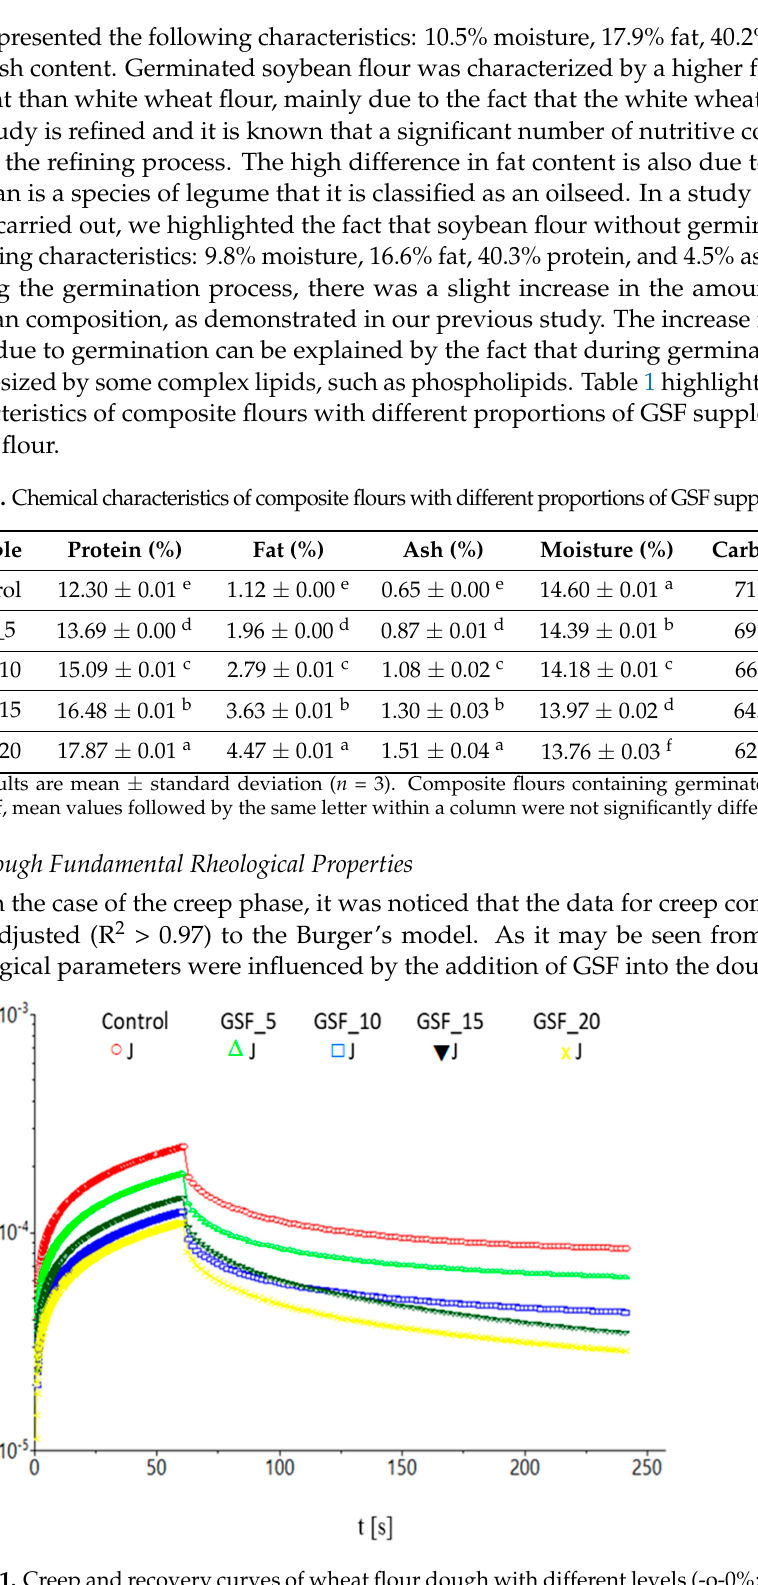
Figure 1. Creep and recovery curves of wheat fl our dough with di ff erent levels (-o-0%; - ∆ -5%; - □ -10%; - ▼ -15%; -x-20%) of germinated soybean fl our additions.